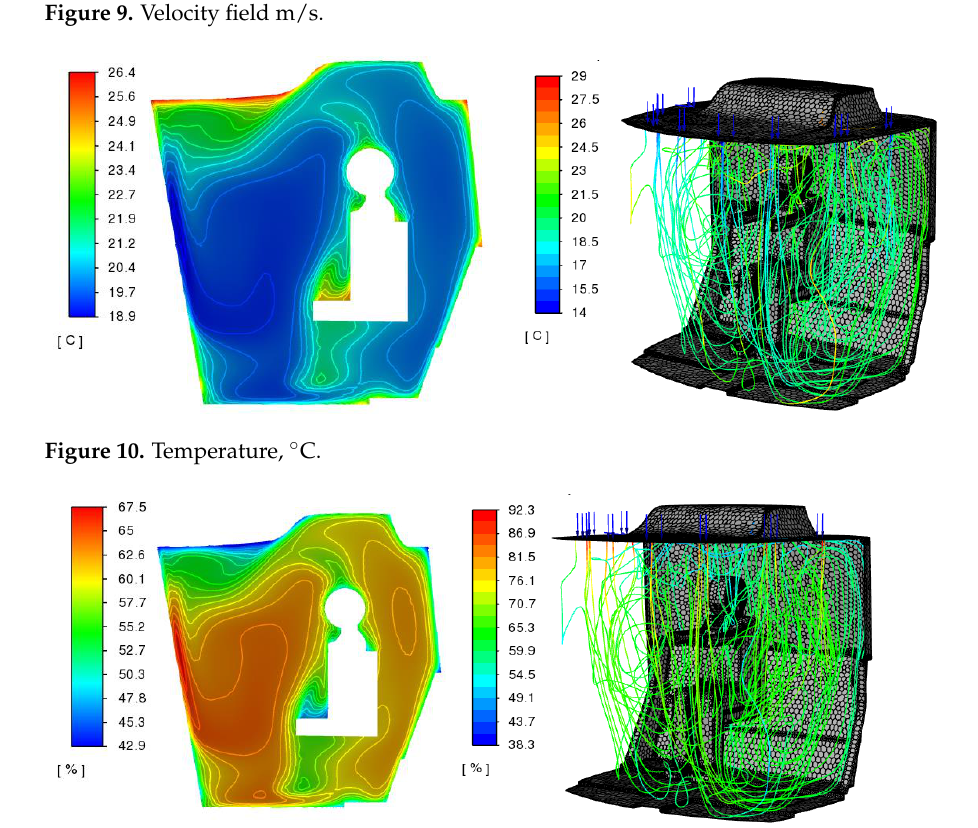
Figure 11. Relative humidity °C.